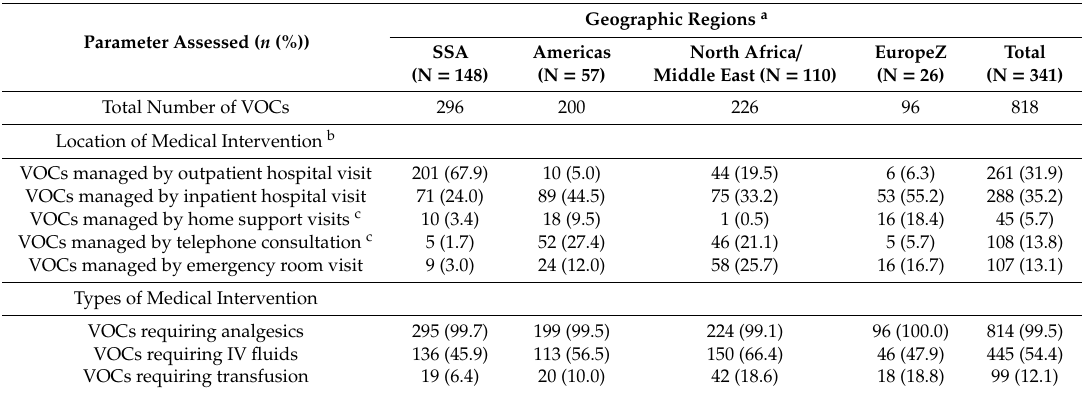
Figure 2. Percentage of vaso-occlusive crises associated with hospitalization during the DOVE study. Note: locations could have included inpatient hospitalizations, outpatient hospitalizations, and emergency room visits: n, number of events in the specified category; VOCs, vaso-occlusive crises. Table 4. Management of VOCs during the DOVE